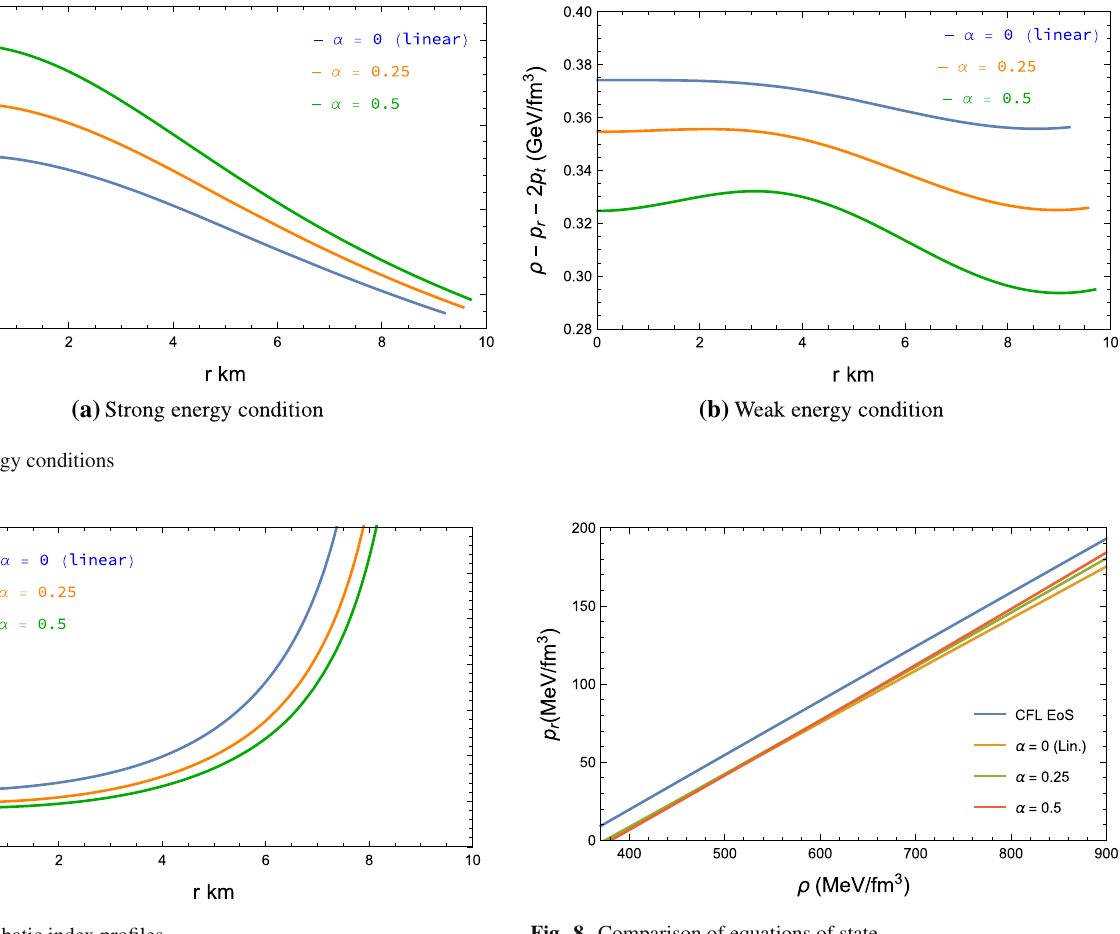
Fig. 8 Comparison of equations of state